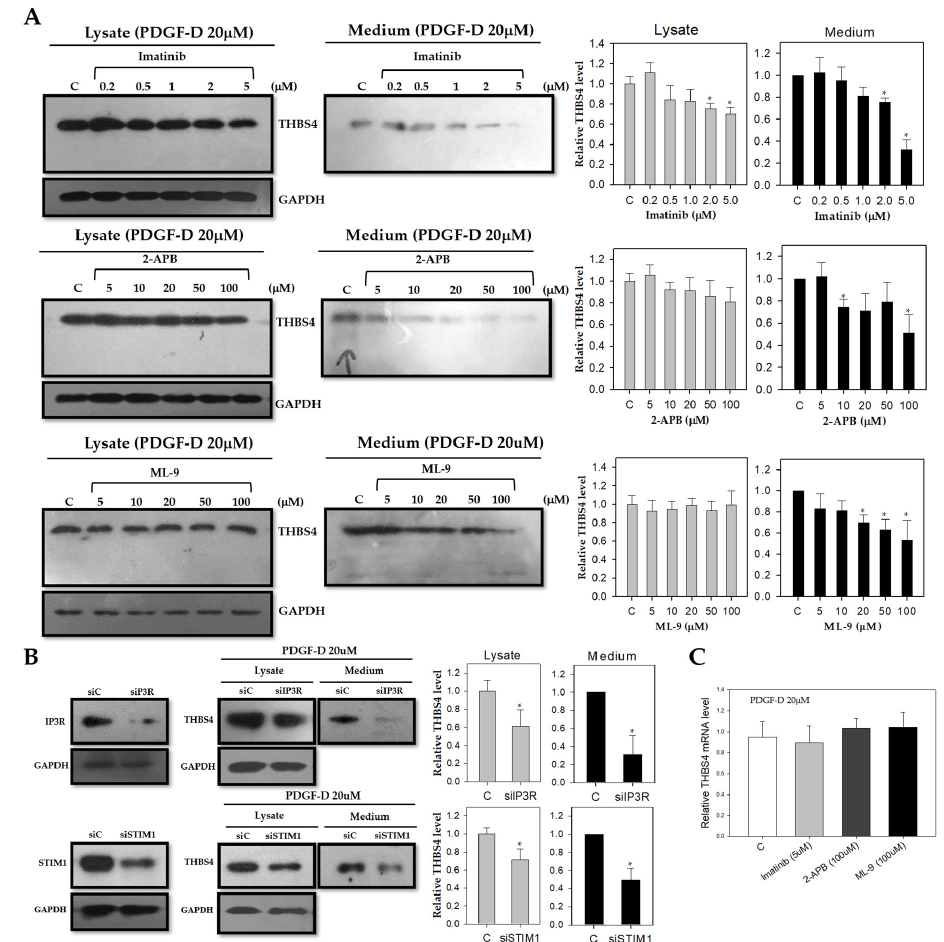
Figure 4. Effect of PDGF-D stimulation of THBS4 after blockage of PDGFR β , IP3R, and STIM1. ( A ) Western blot with anti-THBS4 antibody in whole cell lysate (left panel) or cultured medium (right panel) of DLD-1 cells cultured with PDGF-D (20 µM) for 8 h in the presence of imatinib (0, 0.2, 0.5, 1,